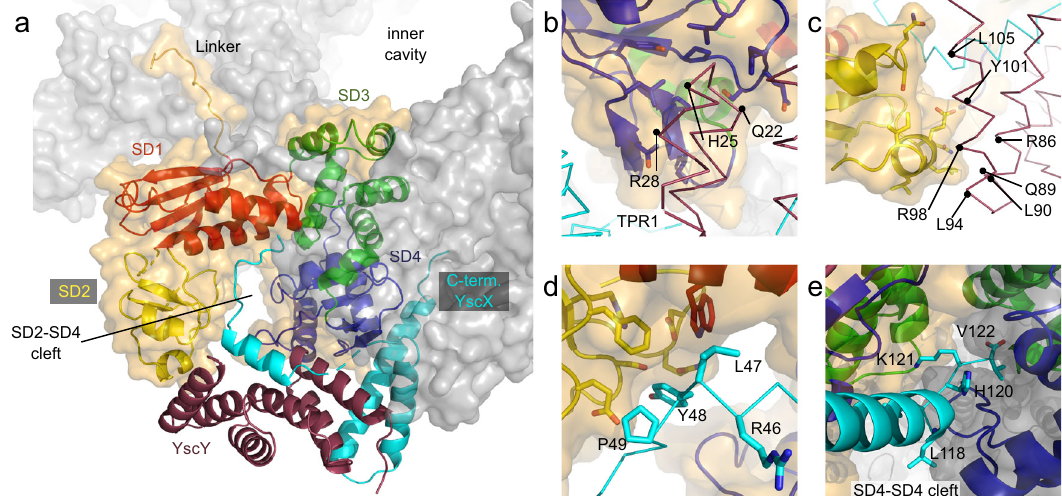
Fig. 4 Interactions of YscV, YscX, and YscY. One YscV C protomer is highlighted (orange surface) within the nonameric ring (gray surface). The cartoon representation of YscV C is divided into the four subdomains: SD1 (red, residues 372 – 438 and 493 – 513), SD2 (yellow, residues 439 – 492), SD3 (green, residues 514 – 600), and SD4 (blue, residues 601 – 704). For clarity, YscX (cyan) and YscY (dark red) are shown only for this heterotrimer and are depicted as ribbon in ( b – d ). a The overall structure of the heterotrimer within the assembly shows that all interactions, except for the insertion of YscX ’ s C-terminus, are con fi ned within one heterotrimer, i.e., YscY does not interact with a neighboring YscV subunit. b YscY interacts with SD4 via the loop of its fi rst TPR (site A) and c with SD2 via the face of its C-terminal TPR (site B). d In chains FB, GB, KB, and LB, YscX exhibits density for an extended N-terminus which binds to SD1 and SD2 via a conserved 46 RLYP 49 motif (site C). Note that the exact positions of the side chains could not be determined at this resolution and are only included for completeness. e The C-terminus of YscX is inserted into the SD4 – SD4 cleft. Both involved YscV C subunits are shown as cartoon colored by subdomain. YscX is shown as ribbon with sidechains starting from